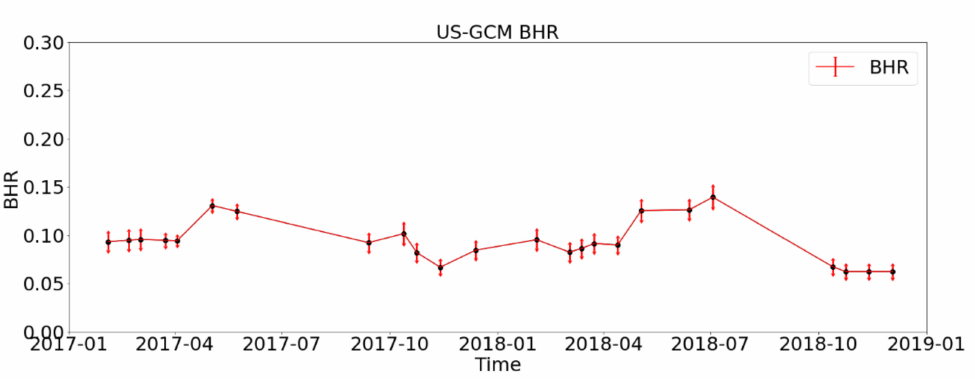
Figure 10. Example of upscaled Direct Hemispherical Reflectance (DHR) and uncertainty values at the US-GCM site.